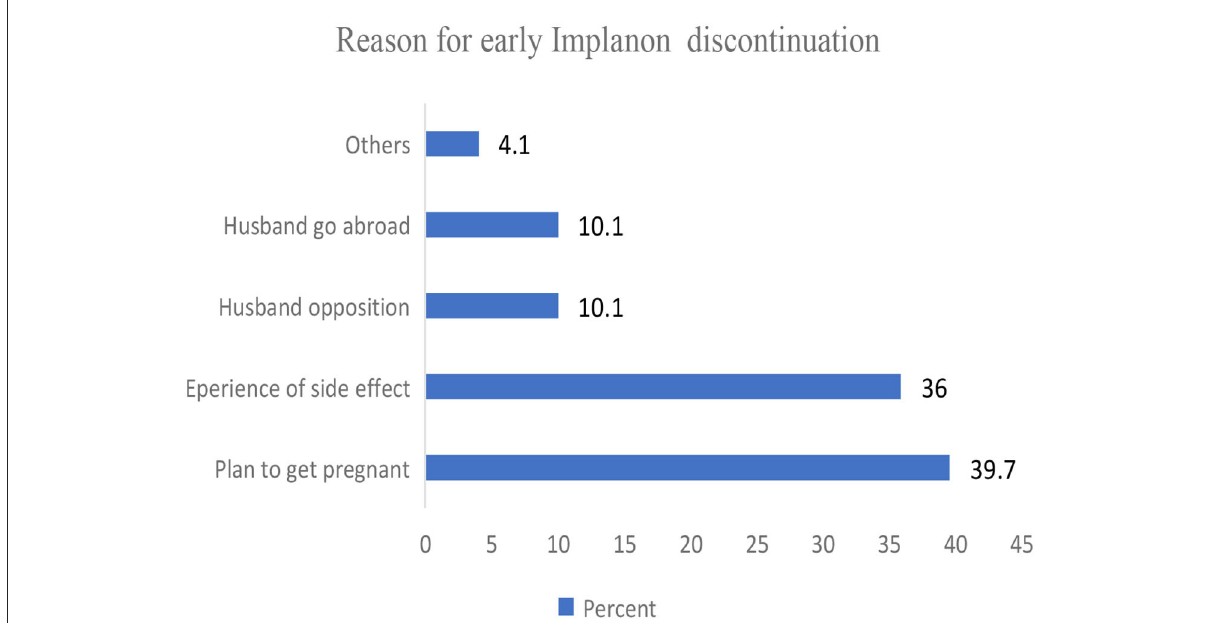
FIGURE3 Reason for early Implanon discontinuation among Implanon users women visiting public health facilities to discontinue Implanon in Kembata Tambaro zone, south Ethiopia, 2020 ( n =